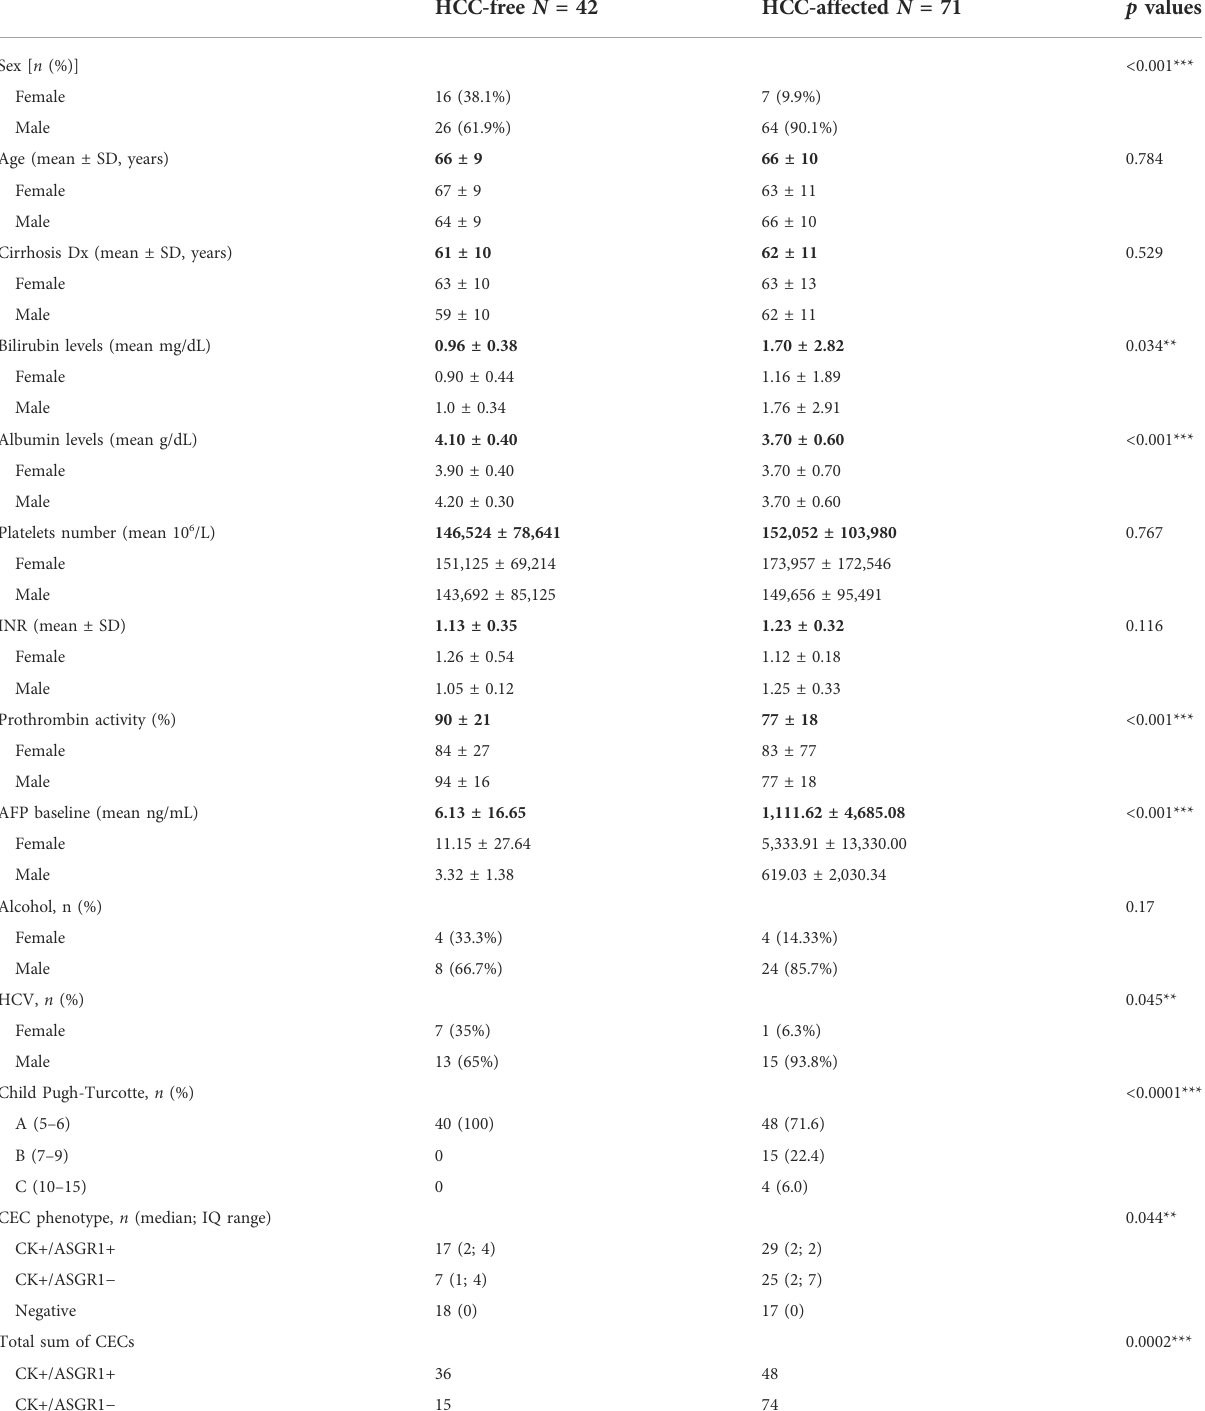
TABLE1RiskfactorsforHCC.Abbreviationsare:HCC,hepatocellularcarcinoma;n,numberofindividuals;SD,standarddeviation;Dx,diagnosis;INR, international normalized ratio; AFP, alpha-fetoprotein; HCV, hepatitis C virus; CEC, circulating epithelial cells; IQ, interquartile; CK, cytokeratin; ASGR1, asialoglycoprotein receptor 1. For quantitative analyses t -student and Mann-Whitney tests were used depending on data normality. For qualitative data, Chi-Square was used except for those cases with less than 20% of the data with lower than 5 expected frequencies, in which case, Fisher test was used. p values are: *** p < 0.001 and ** p < 0.05. Bold is the mean for each value as a